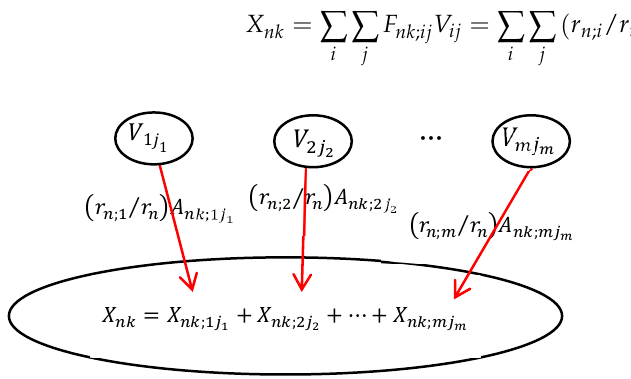
Figure 2. The causal mechanism of the DUCG.